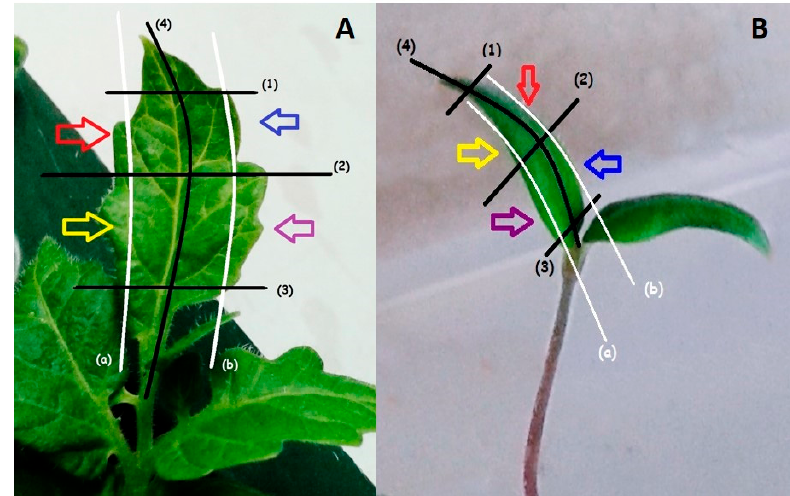
Figure 1. Schematic presentation of explants cuttings used in the regeneration experiment: ( Α ) leaf and ( Β ) cotyledon. Horizontal lines 1–3 represent incisions on leaves and cotyledons, while Line 4 was made across the central neuron of each explant type. Vertical Line 4 represents the vertical incision across the central nerve of the leaf and Lines A and B the vertical incisions that ultimately produced the four excised cuttings (indicated with arrows).